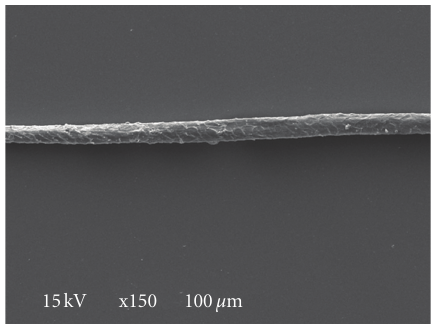
Figure 4: Untreated blackish brown wool fiber ( × 150).